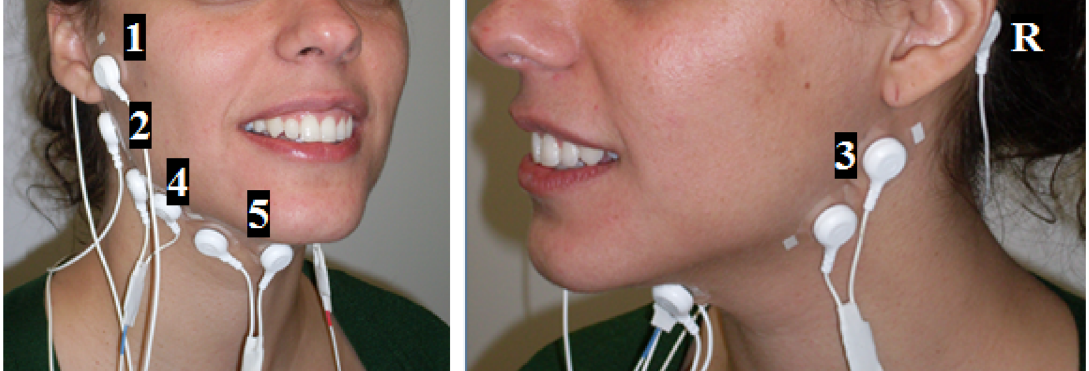
Fig 5. EMG electrodes positioning and the respective channels (1 to 5) plus the reference electrode (R). EMG 1 and 2 use unipolar configurations and EMG 3, 4 and 5 use bipolar configurations.